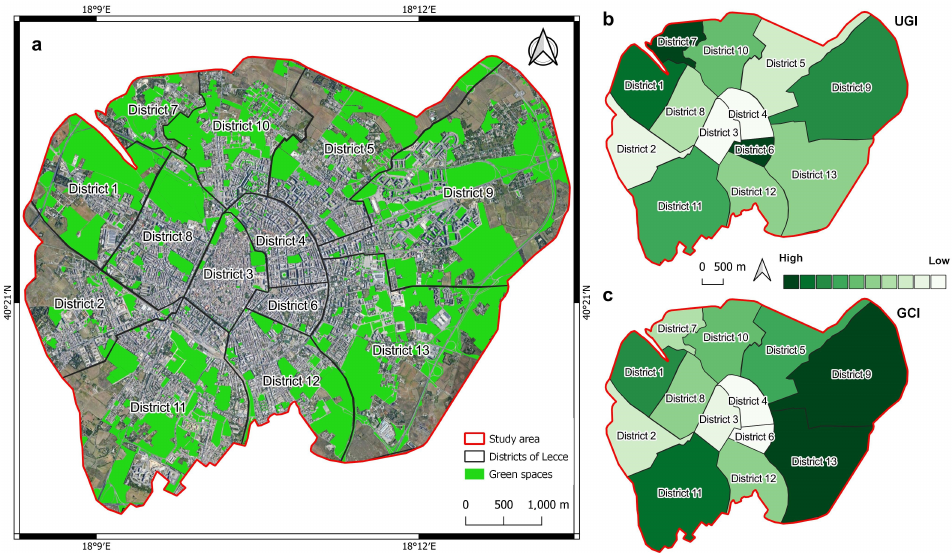
Figure 4. ( a ) Urban greenery map of the municipality of Lecce; ( b ) Districts’ Urban Green Index (UGI) Map; ( c ) Districts’ Green Connectivity Index (GCI)